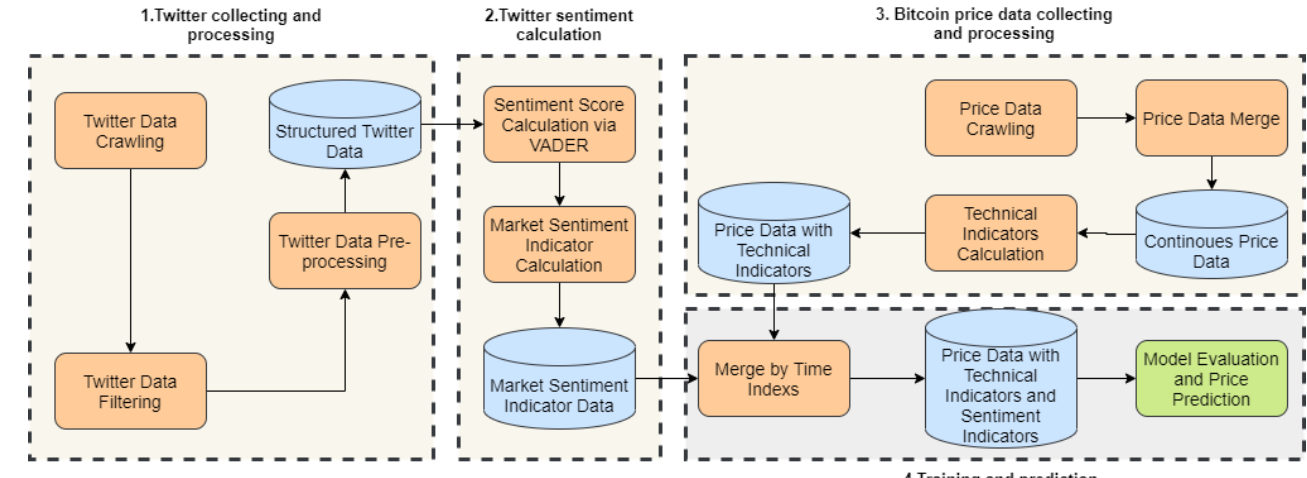
Figure 2. The proposed model workflow for Bitcoin price prediction using